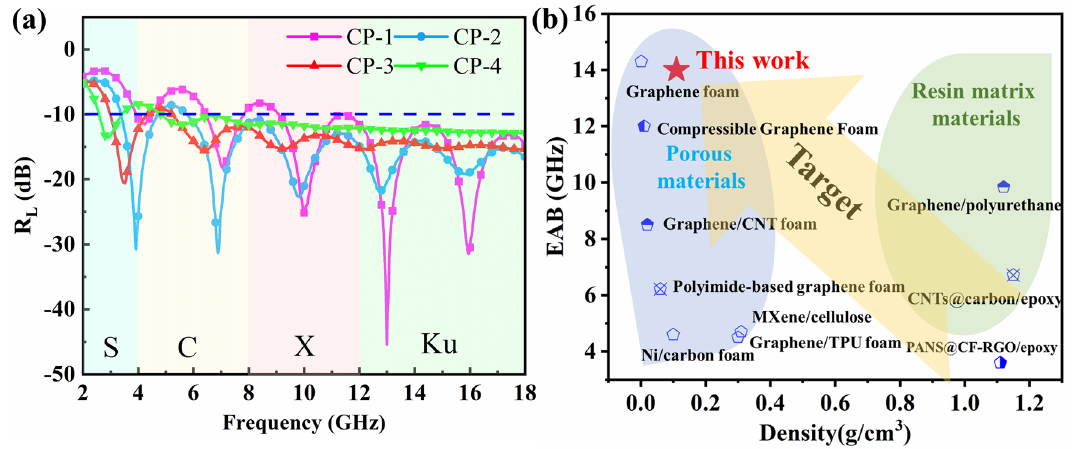
Fig. 3 a R L curves of CP composites with the thickness of 4 cm, b comparison with the MA properties of other absorbers reported